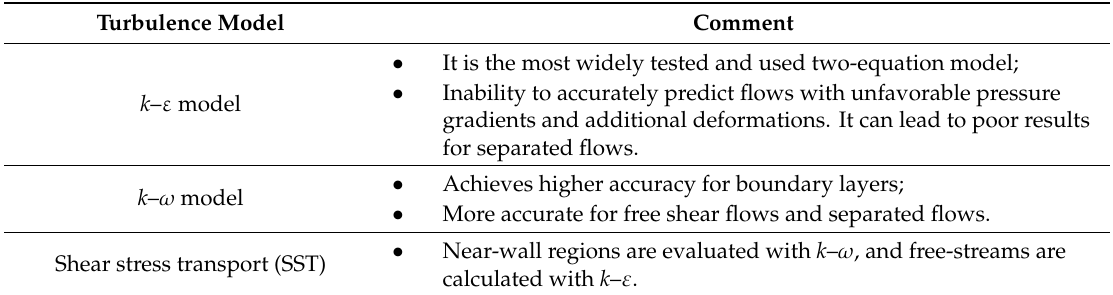
Table 3. Turbulence models used in two-phase flow computational fluid dynamics